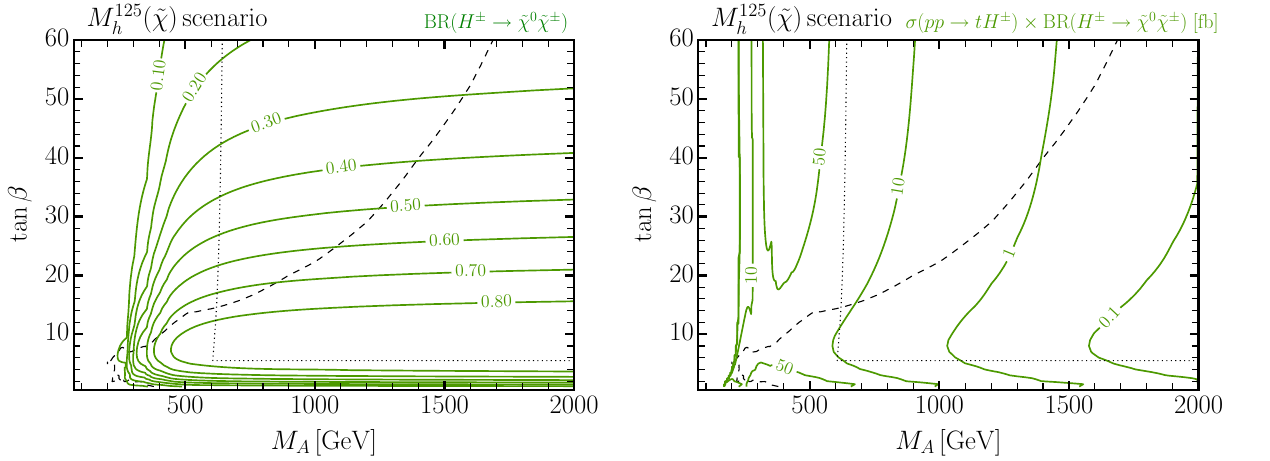
Fig. 8 Left:Branchingratioforthecharged-Higgsdecaystochargino– charged Higgs boson in association with a top quark, followed by its ( ˜ χ) scenario. neutralino pairs, as a function of M A and tan β in the M 125 decay to EW-inos, at the LHC with 13TeV center-of-mass energy. In h each plot, the boundaries of the blue and the hatched exclusion regions A sum is taken over all the kinematically allowed combinations of par- ticles in the final state. Right: Total rate (in fb) for the production of a of Fig.5 are shown as a dashed and a dotted black line,